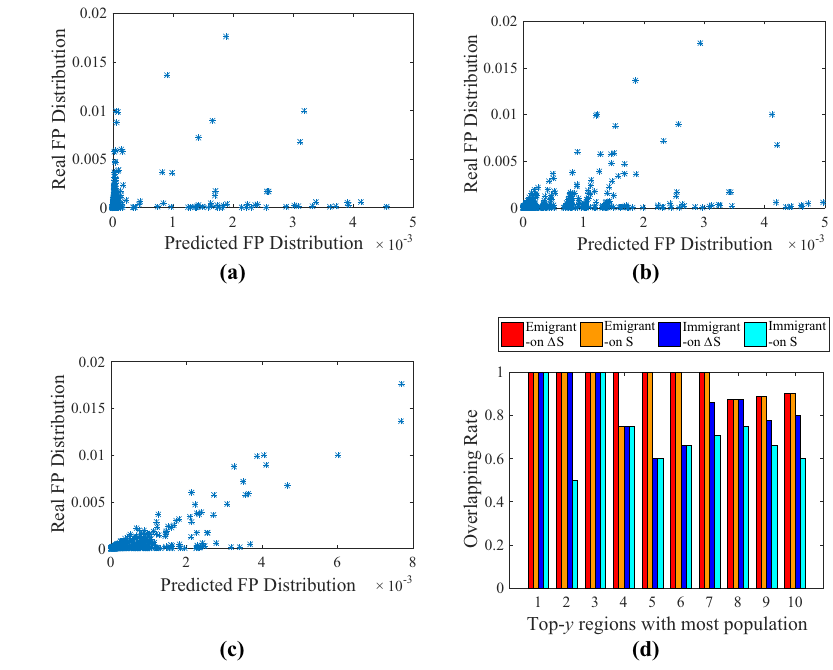
Figure 7. Results of inferring the FP that has excluded those whose home and remote regions are the